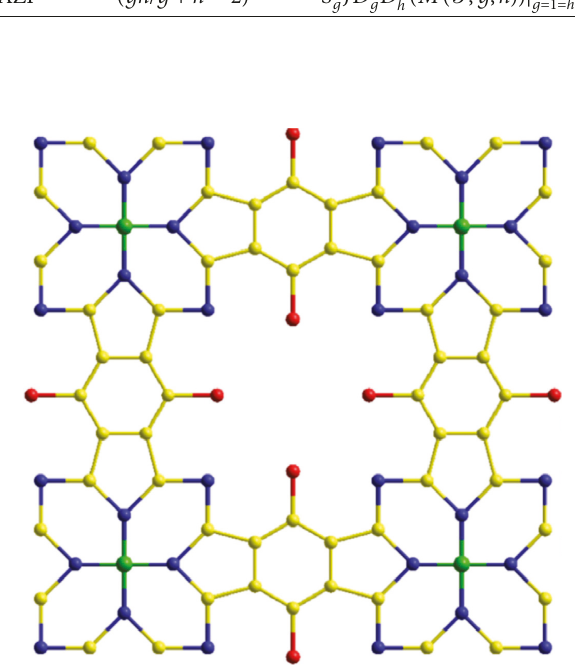
Figure 1: Transition metal tetra-cyano-benzene organic network.